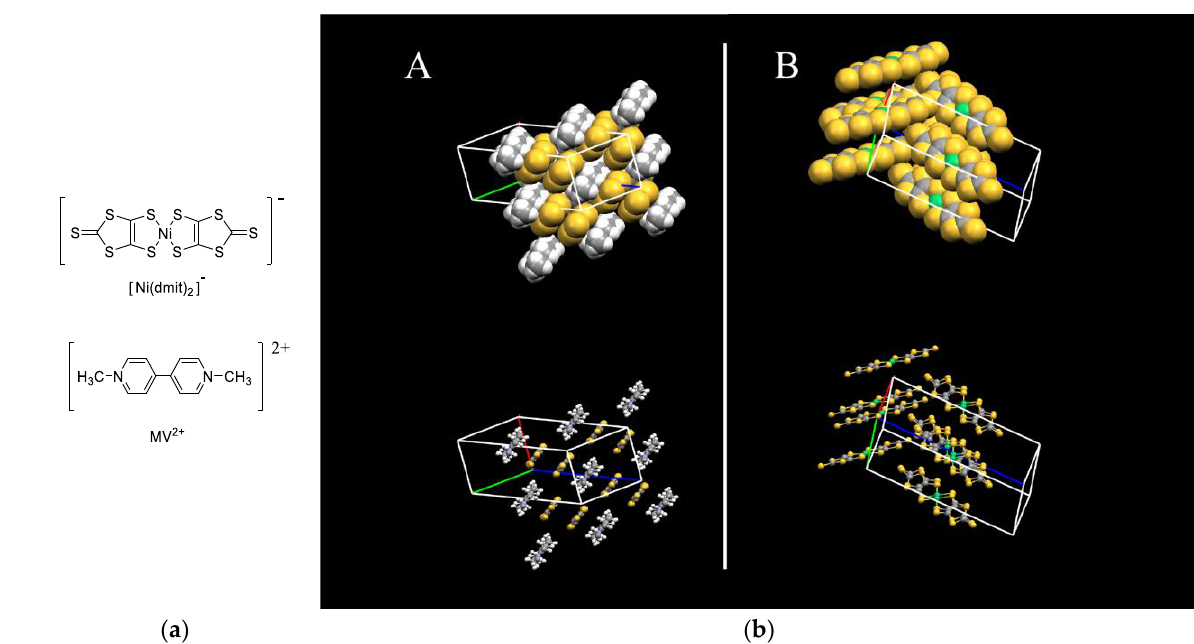
Figure 8. The crystal structure of a photomagnetic conductor, MV[Ni(dmit) 2 ] 2 : ( a ) MV 2+ and [Ni(dmit) 2 ] − ; ( b ) Molecular packing motif in van der Waals (upper) and ball-and-stick (lower) models; ( A ) Chemical structures of MV 2+ and [Ni(dmit) 2 ] − and ( B ) 3D conduction pathways composed of [Ni(dmit) 2 ] − . MV[Ni(dmit) 2 ] 2 is a diamagnetic insulator under dark conditions, but it turns into a metallic substance with localized spins on the MV 2+ species under UV irradiation, thus exhibiting the Kondo effect at low temperature. The UV (~375 nm) irradiation triggers a CT transition between MV 2+ and [Ni(dmit) 2 ] − .